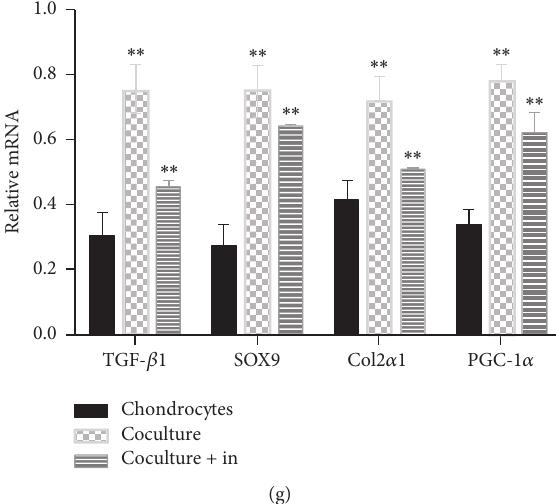
Figure 6: Mechanisms of promoting effect of ADSCs on chondrocytes investigated by western blot ((a), (b), (e), and (f)), real-time PCR ((c),(g)), and ELISA kit (d). Chondrocytes were cultured in control medium (chondrocytes) , ADSCs cocultured system (coculture), TGF- 𝛽 1-containing medium (TGF- 𝛽 1), and ADSCs cocultured system plus TGF- 𝛽 1 inhibitor (coculture + in) for 5 days. Both western blot ((a), (b), (e), and (f)) and real-time PCR ((c), (g)) results indicated that TGF- 𝛽 1 level in chondrocytes either cocultured with ADSCs or cultured with TGF- 𝛽 1-containing medium was upregulated. Furthermore, chondrocytes produced more the following proteins and genes including SOX-9, collagen type II ( 𝛼 1), and PGC-1 𝛼 when they were cultured with either TGF- 𝛽 1-containing medium or ADSCs cocultured system. In addition, the production of glycosaminoglycan (GAG) in chondrocytes cocultured with ADSCs was also increased. However, after adding TGF- 𝛽 1 inhibitor to ADSCs cocultured system, the production of GAG in chondrocytes was decreased (d). Furthermore, all the above- mentioned proteins and genes were decreased in chondrocytes cultured with ADSCs plus TGF- 𝛽 1 inhibitor ((e), (f) and (g)). Data are shown as mean ± SEM. ∗∗ 𝑝 < 0.01 versus chondrocytes